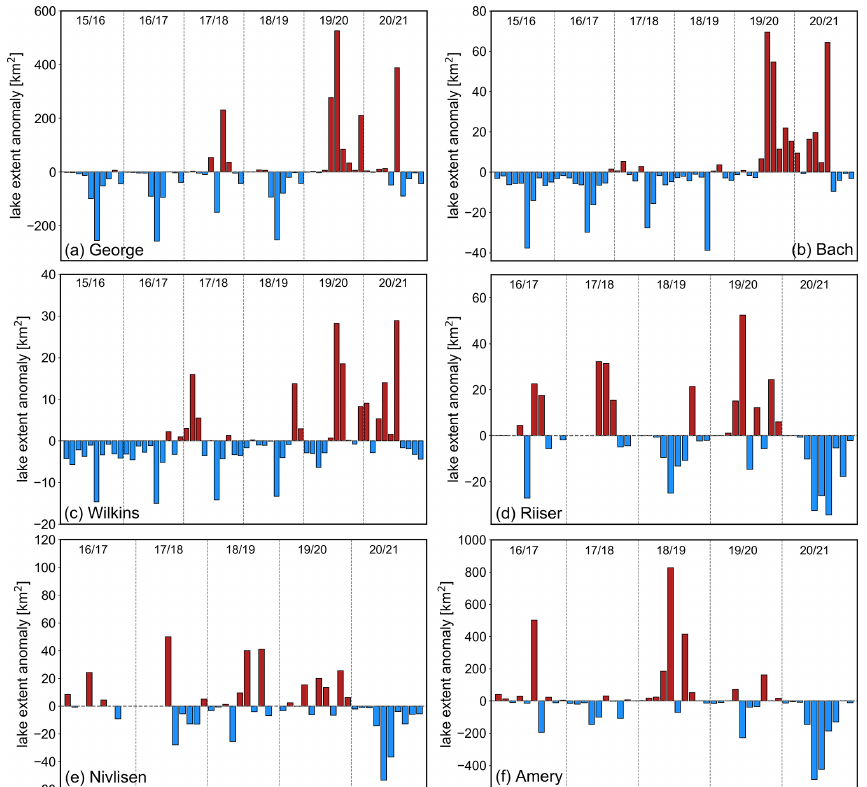
Figure 4. Intra-annual supraglacial lake extent anomalies over (a) George VI, (b) Bach, (c) Wilkins, (d) Riiser-Larsen, (e) Nivlisen and (f) Amery ice shelves, as calculated with respect to the long-term mean 2015–2021 of each bi-weekly time interval within the investigation period 2015–2021. For Riiser and Nivlisen ice shelves, data gaps are visible due to interpolation with the bi-weekly long-term mean 2016– 2021. Each bar represents a bi-weekly time interval within the period November to March of an individual melting season. Melting seasons are outlined through separation with dashed grey lines.